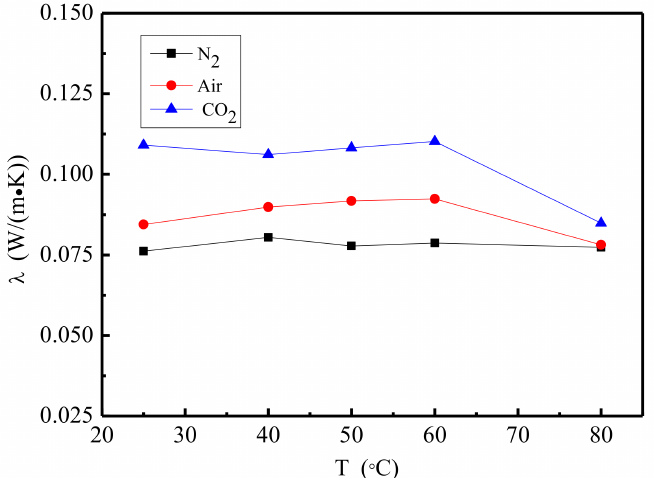
Figure 7. The effective thermal conductivity of the solid amine at different temperatures and different atmospheres.